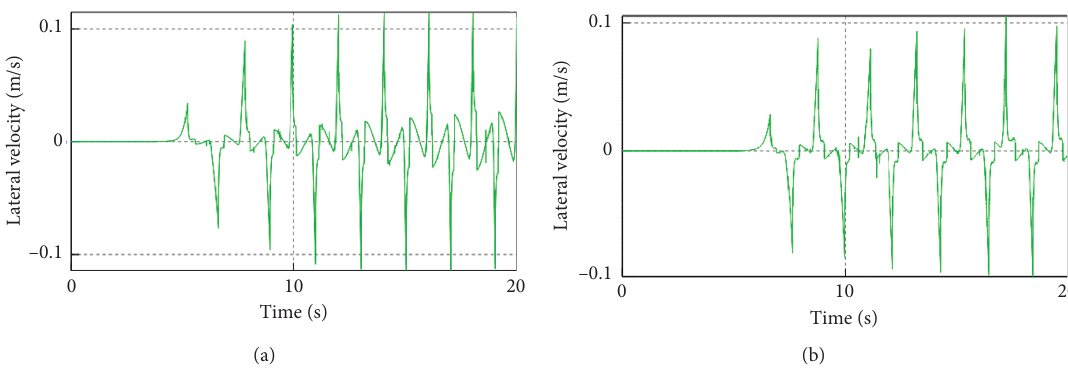
Figure 21: Changes of the lateral velocity under different supporting wheel treads: (a) 322mm and (b) 522 mm.